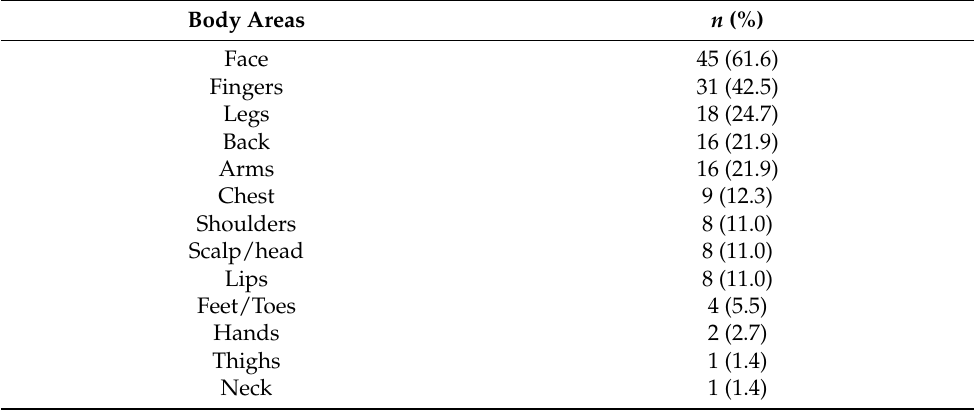
Table 1. Picking sites among participant with SPD ( n = 73). Body